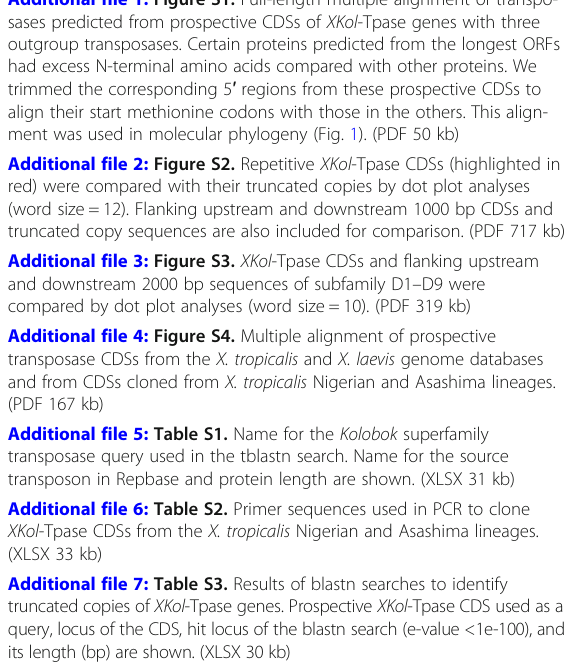
Additional file 1: Figure S1. Full-length multiple alignment of transpo- sases predicted from prospective CDSs of XKol -Tpase genes with three outgroup transposases. Certain proteins predicted from the longest ORFs had excess N-terminal amino acids compared with other proteins. We trimmed the corresponding 5 ′ regions from these prospective CDSs to align their start methionine codons with those in the others. This align- ment was used in molecular phylogeny (Fig. 1). (PDF 50 kb) Additional file 2: Figure S2. Repetitive XKol -Tpase CDSs (highlighted in red) were compared with their truncated copies by dot plot analyses (word size =12). Flanking upstream and downstream 1000 bp CDSs and truncated copy sequences are also included for comparison. (PDF 717 kb) Additional file 3: Figure S3. XKol -Tpase CDSs and flanking upstream and downstream 2000 bp sequences of subfamily D1 – D9 were compared by dot plot analyses (word size =10). (PDF 319 kb) Additional file 4: Figure S4. Multiple alignment of prospective transposase CDSs from the X. tropicalis and X. laevis genome databases and from CDSs cloned from X. tropicalis Nigerian and Asashima lineages. (PDF 167 kb) Additional file 5: Table S1. Name for the Kolobok superfamily transposase query used in the tblastn search. Name for the source transposon in Repbase and protein length are shown. (XLSX 31 kb) Additional file 6: Table S2. Primer sequences used in PCR to clone XKol -Tpase CDSs from the X. tropicalis Nigerian and Asashima lineages. (XLSX 33 kb) Additional file 7: Table S3. Results of blastn searches to identify truncated copies of XKol -Tpase genes. Prospective XKol -Tpase CDS used as a query, locus of the CDS, hit locus of the blastn search (e-value <1e-100), and its length (bp) are shown. (XLSX 30